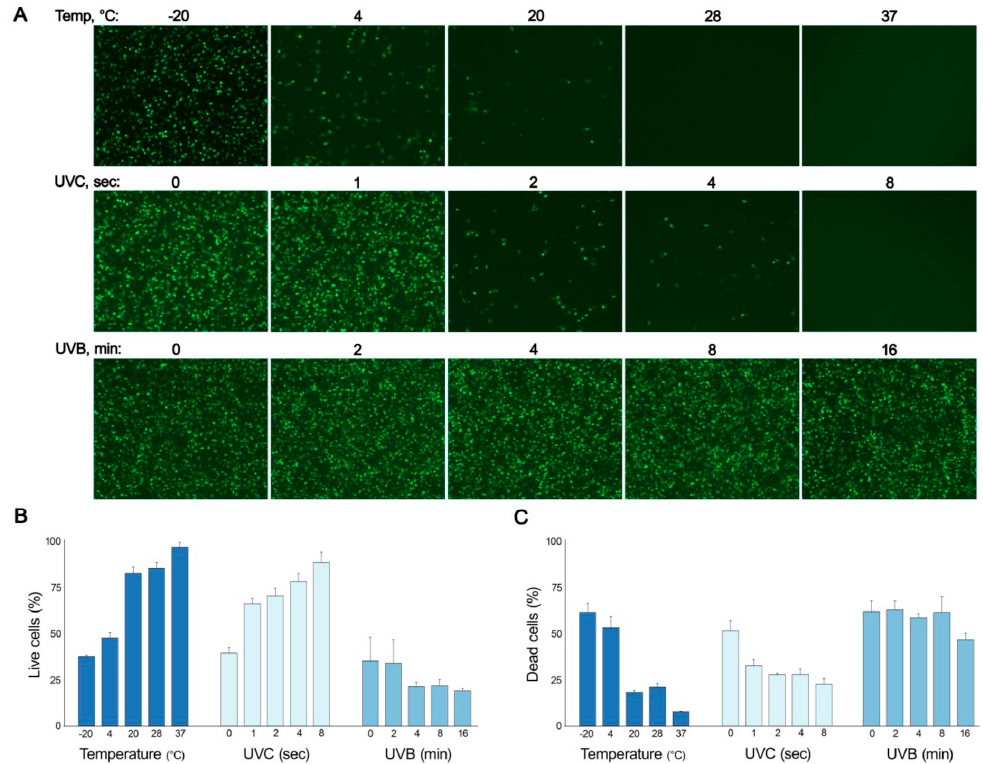
Figure 4. Effect of temperature and UV radiation on infectivity of GFP-encoding influenza A virus (PR8-GFP). ( A ) PR8-GFP was incubated at indicated temperatures for 48 h or exposed to UVB or UVC radiation for the indicated times. Human telomerase reverse transcriptase-immortalized retinal pigment (RPE) cells were subsequently infected with the virus. GFP expression was visualized using fluorescent microscopy. The size of each image corresponds to 1000 × 1250 µ M 2 . ( B ) Viruses were obtained and RPE cells were infected as for (A). Viability of cells were measured using Cell Titer Glow assay. Mean ± SD, n = 3. ( C ) Viruses were obtained and RPE cells were infected as for panel A. Death of cells were measured using Cell Tox Green assay. Mean ± SD, n = 3.